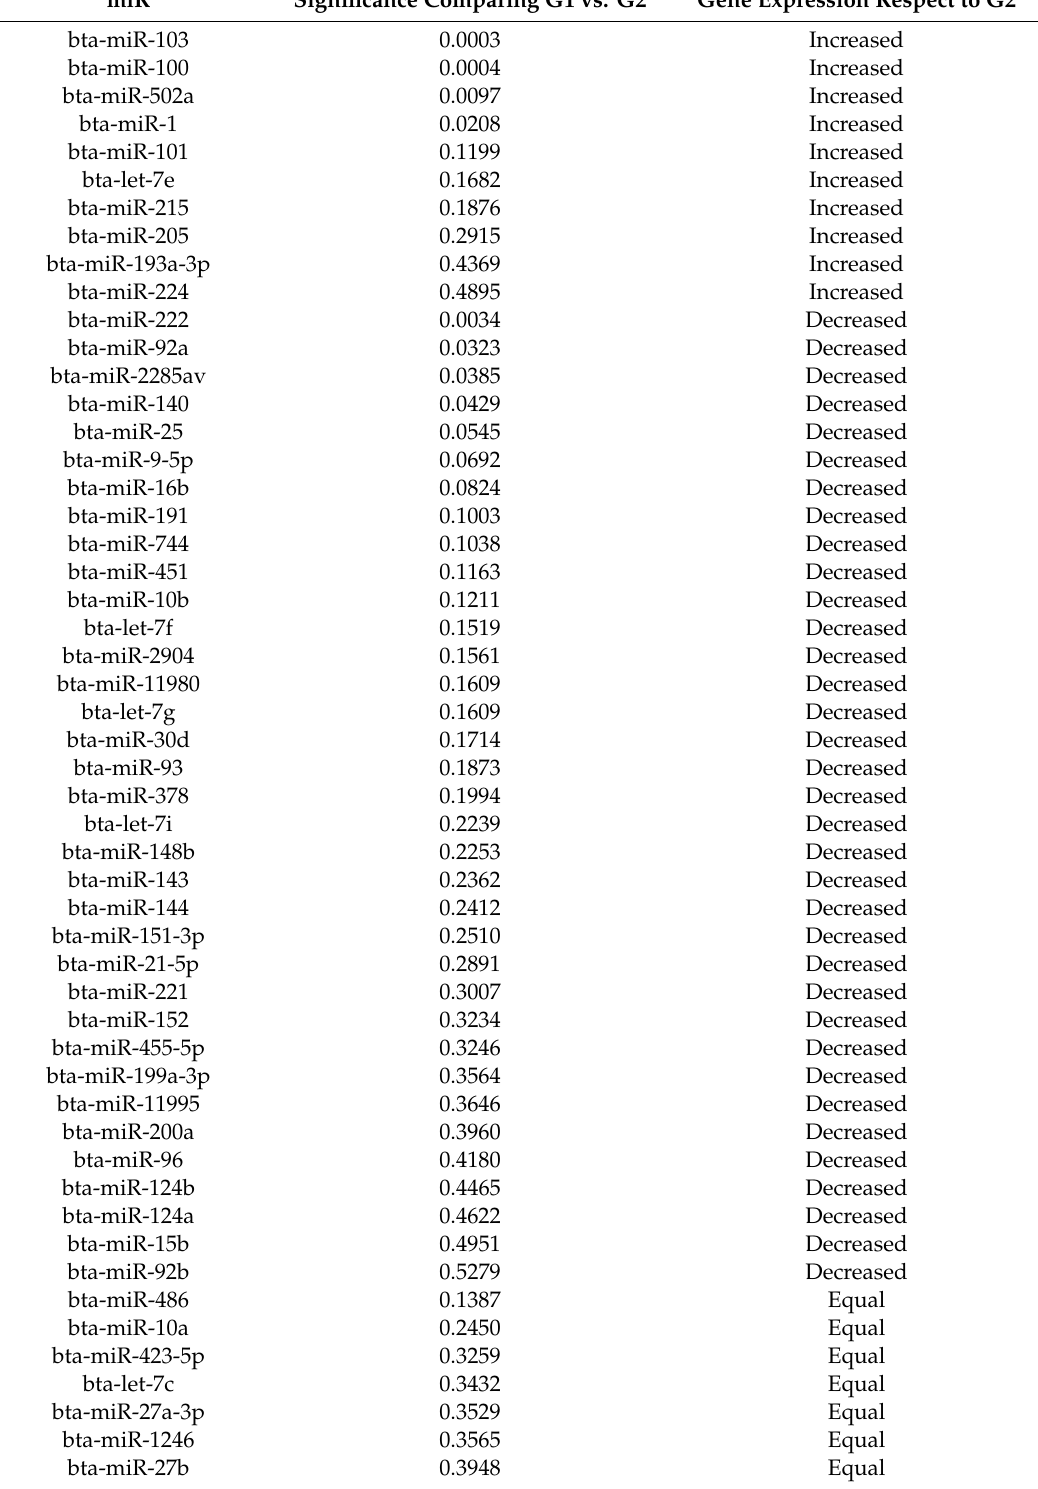
Table 1. MiRNAs identified in extracellular vesicles secreted by bovine embryos during the compaction